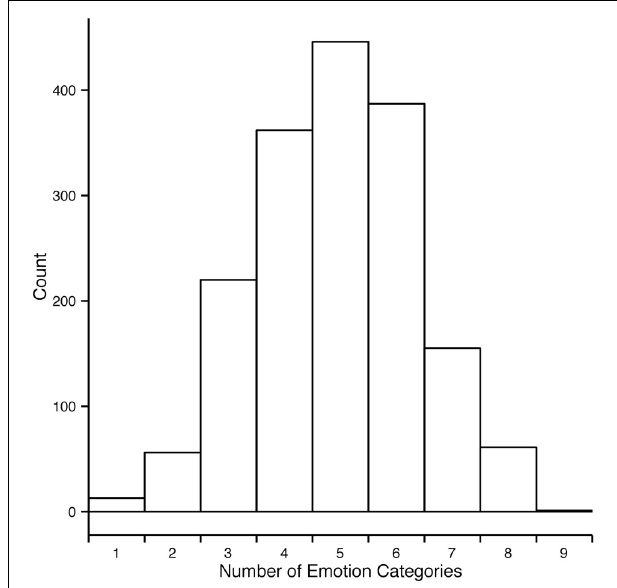
total eleven responses. For most motion sequences the responses fall into five or fewer categories.